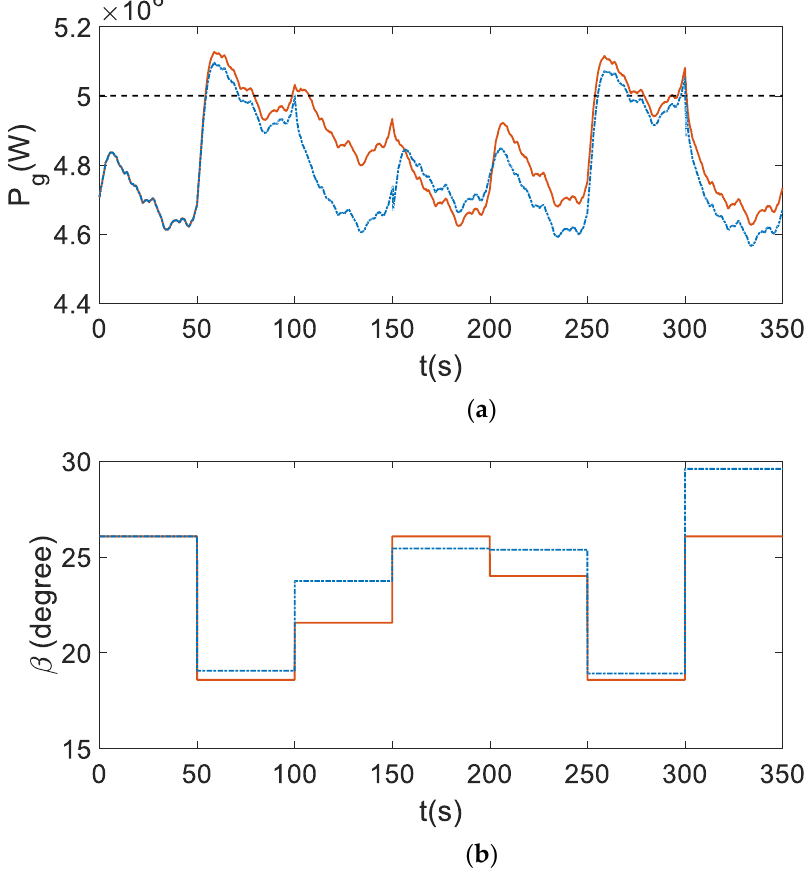
Figure 10. ( a ) Output power P g and ( b ) pitch angle β of WPGS for the robust MPC (red solid line) and stochastic MPC (blue dotted line) in the high wind speed region with slight turbulence.